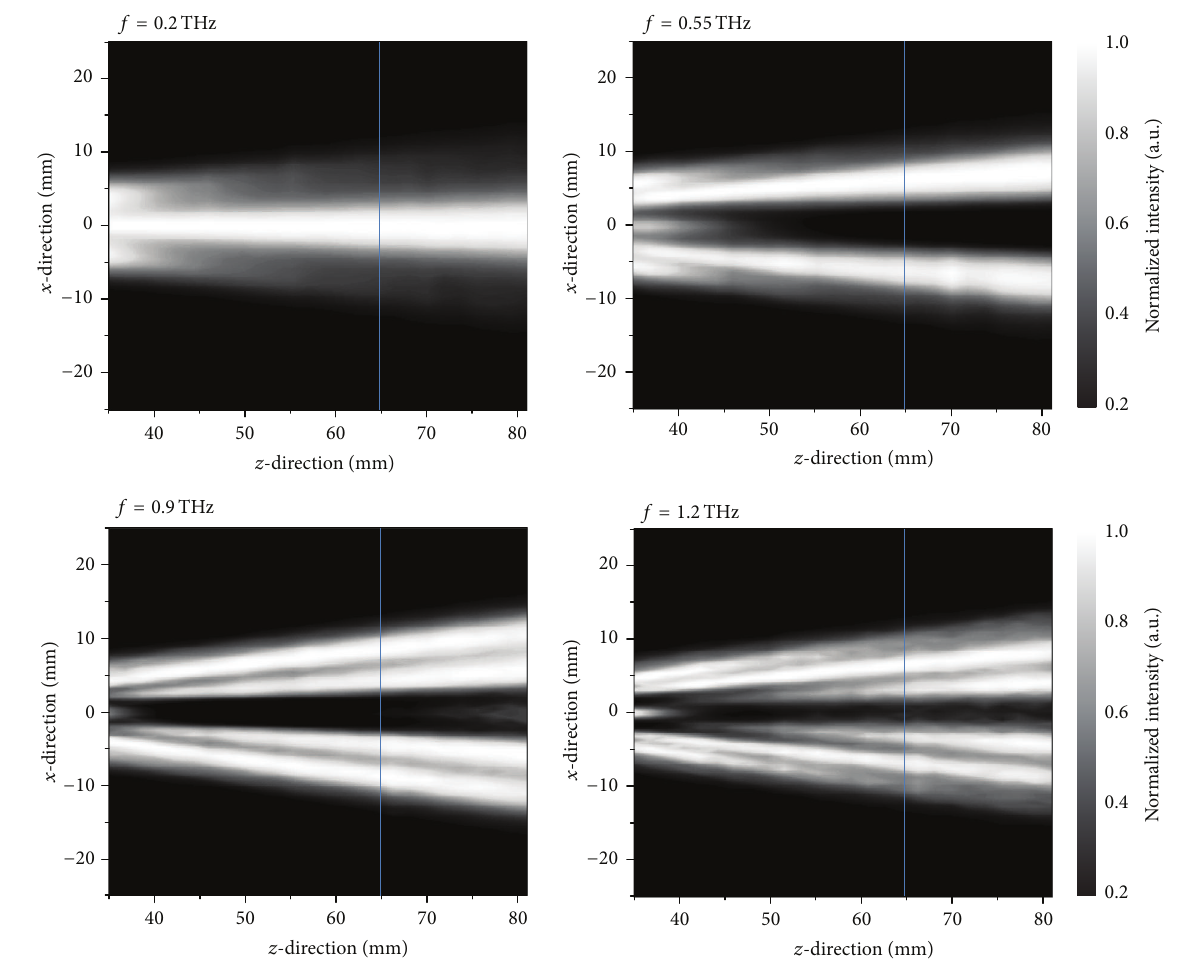
Figure 7: THz patterns at different distances to the detector in a range of 35 to 80mm in 𝑧 -direction and − 25 mm to 25 mm in 𝑥 -direction for 0.2 THz, 0.55 THz, 0.9 THz, and 1.2 THz. The blue lines mark the position for the spectrally resolved distributions shown in Figure 8.